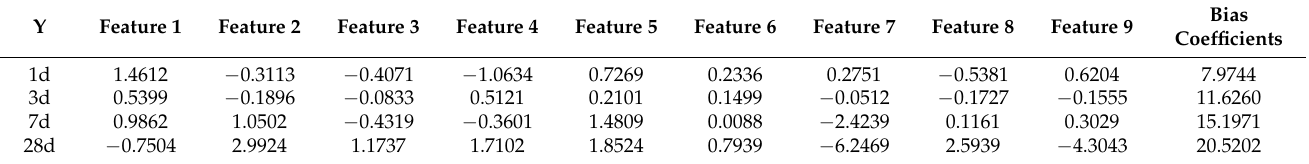
Table 6. Weights and bias coefficients of each